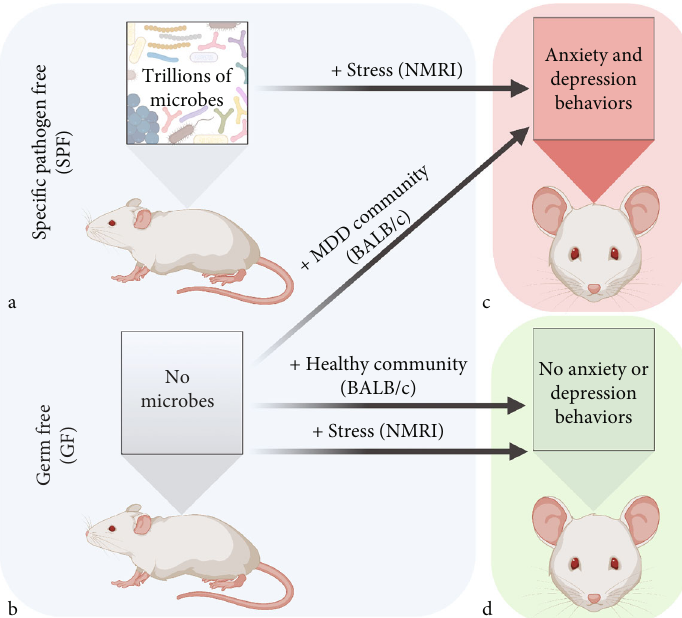
Figure 1: Anxiety and depression SPF and GF mouse models. (a) Speci fi c pathogen free (SPF) mice are exposed to microbes and develop mature populations containing trillions of microbes throughout their body (e.g., skin, genital, and intestinal tract). SPF colonized mice have mature immune systems and are often used as the wild-type microbial community background in murine studies. (b) Germ free (GF) mice are bred without exposure to any microbes and are often used to study microbial community or speci fi c population member (monocolonization) impact on host health. SPF and GF mice can be studied on varied genetic backgrounds (e.g., BALB/c and NMRI). (c, d) When exposed to stress (+Stress), SPF mice develop anxiety and depression behaviors while GF mice do not display these behaviors under stress or in the presence of a healthy community (+Healthy Community). GF mice do display anxiety and depression when colonized with a human microbial community from patients with major depressive disorder (+MDD Community) ( fi gure created with